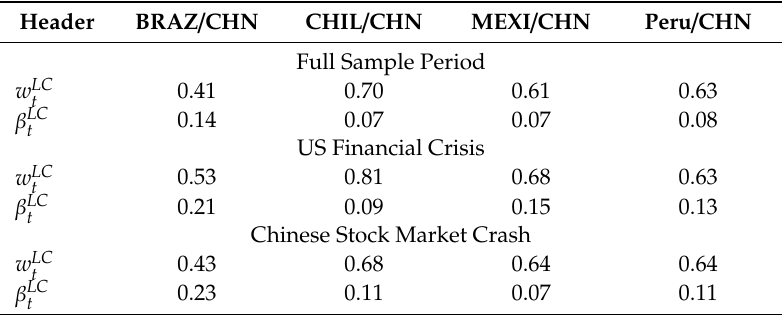
Table 10. Optimal weights and hedge ratios for LA / China Header BRAZ / CHN CHIL / CHN MEXI / CHN Peru / CHN Full Sample Period 0.41 0.70 w LC t